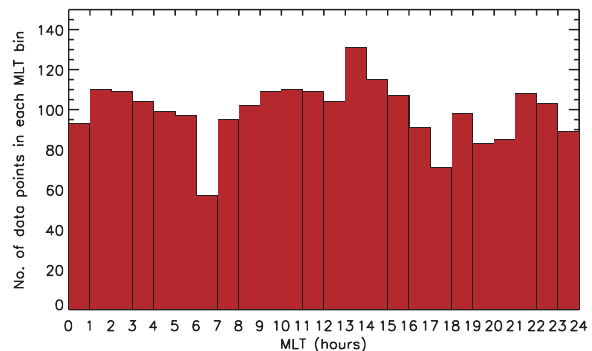
Fig. 3. Histogram of the number of Ion Distribution Functions (IDFs) in each MLT